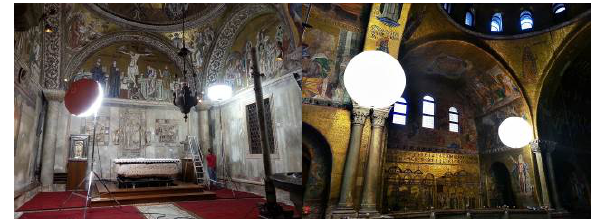
Figure 4: Lighting systems during the acquisition stage: detail of the balloons.